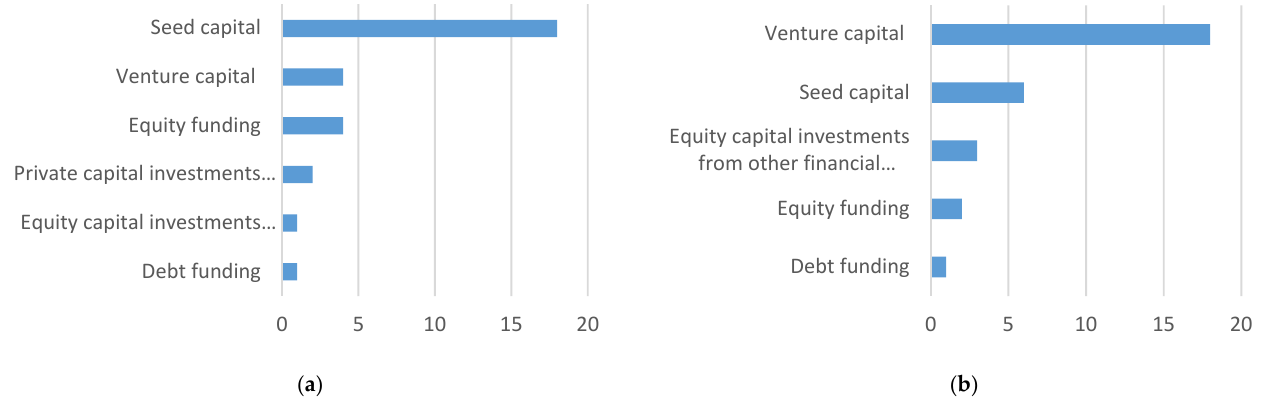
Figure 5. Answers to the question of what sources of funding companies consider the most important for the FinTech sector in the next three years: ( a ) First choice; ( b ) Second choice, number of responses. As for cooperation with specialized organizations, the respondents cooperate mainly with the national regulator, the Financial and Capital Market Commission (26% of the respondents), the Latvian Startup Association (26%), and the Investment and Development Agency of Latvia (13%). At the same time, 26% of the respondents do not cooperate with specialized organizations at